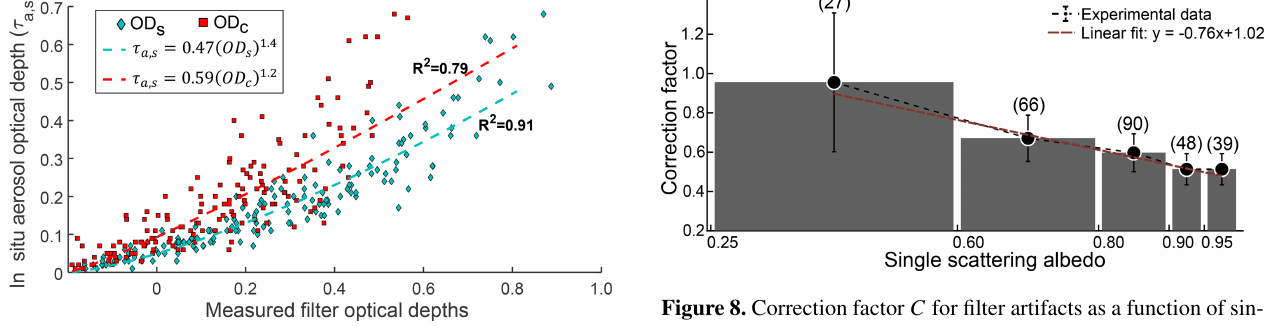
Figure 7. Relationship between in situ aerosol optical depth ( τ a , s ) and measured values of filter optical depth measures OD c and OD s for a subset of 54 filter samples, measured at 375, 405, and 532nm ( N = 162 data points). Uncertainties were as in Fig. 6.